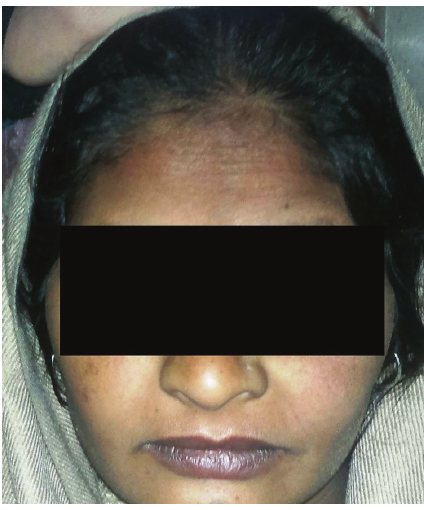
Figure 1: Flat nasolabial fold and inability to wrinkle the forehead (right side).